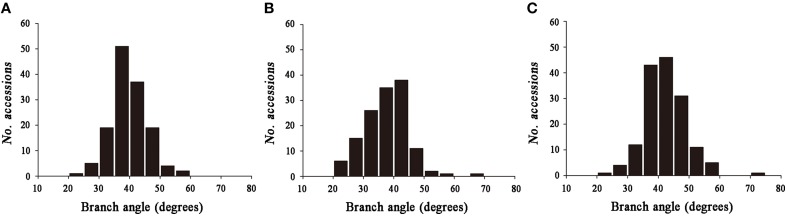
The frequency distribution for branch angle in three environments. (A) 2013YL; (B) 2014YL; (C) 2013LA.